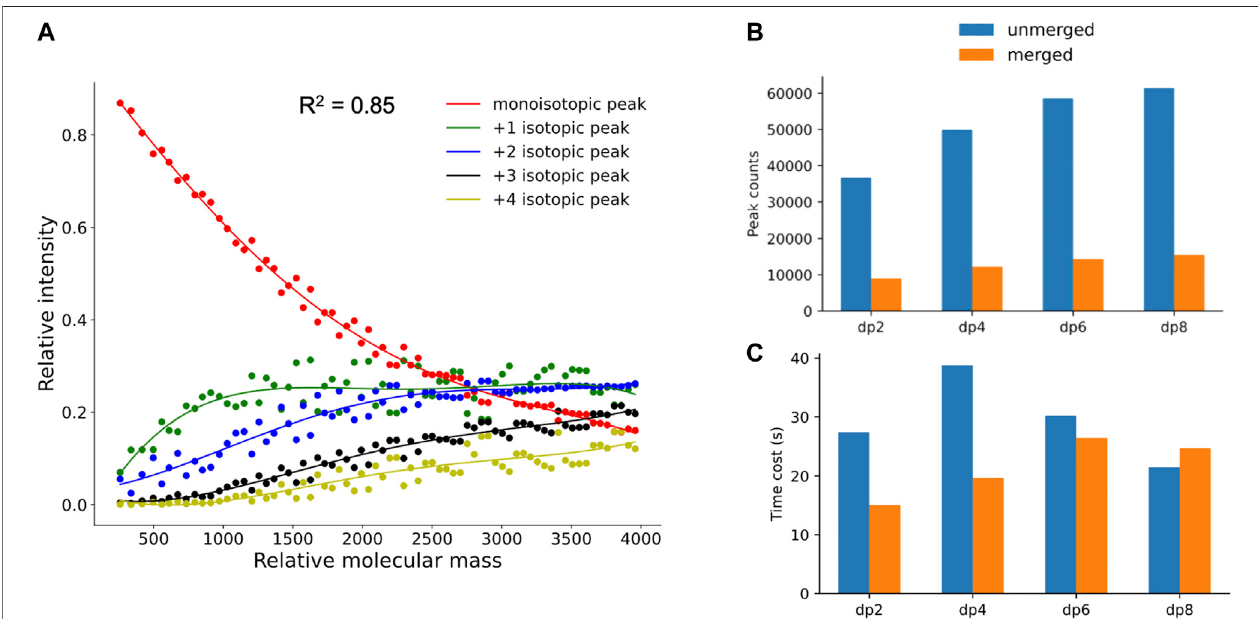
FIGURE 4 | (A) Fitting results of theoretical isotopic peak distribution. (B,C) Comparison of peak number and time cost between unmerged spectra and merged spectra in dp2, dp4, dp6, and dp8 oligosaccharides.